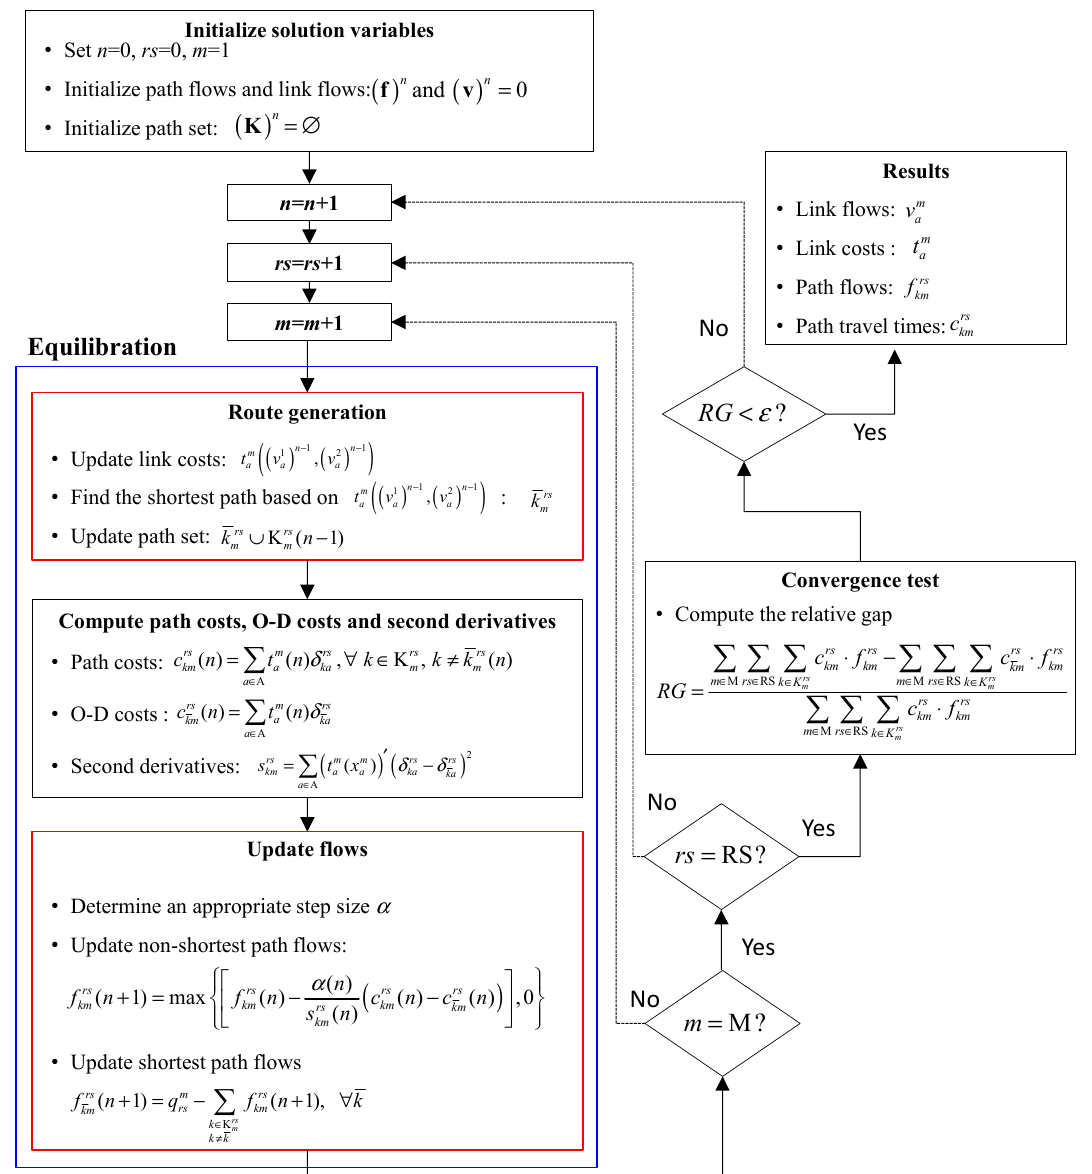
Figure 3. Solution procedure strategy for the multi-class TAP with asymmetric vehicle interactions.